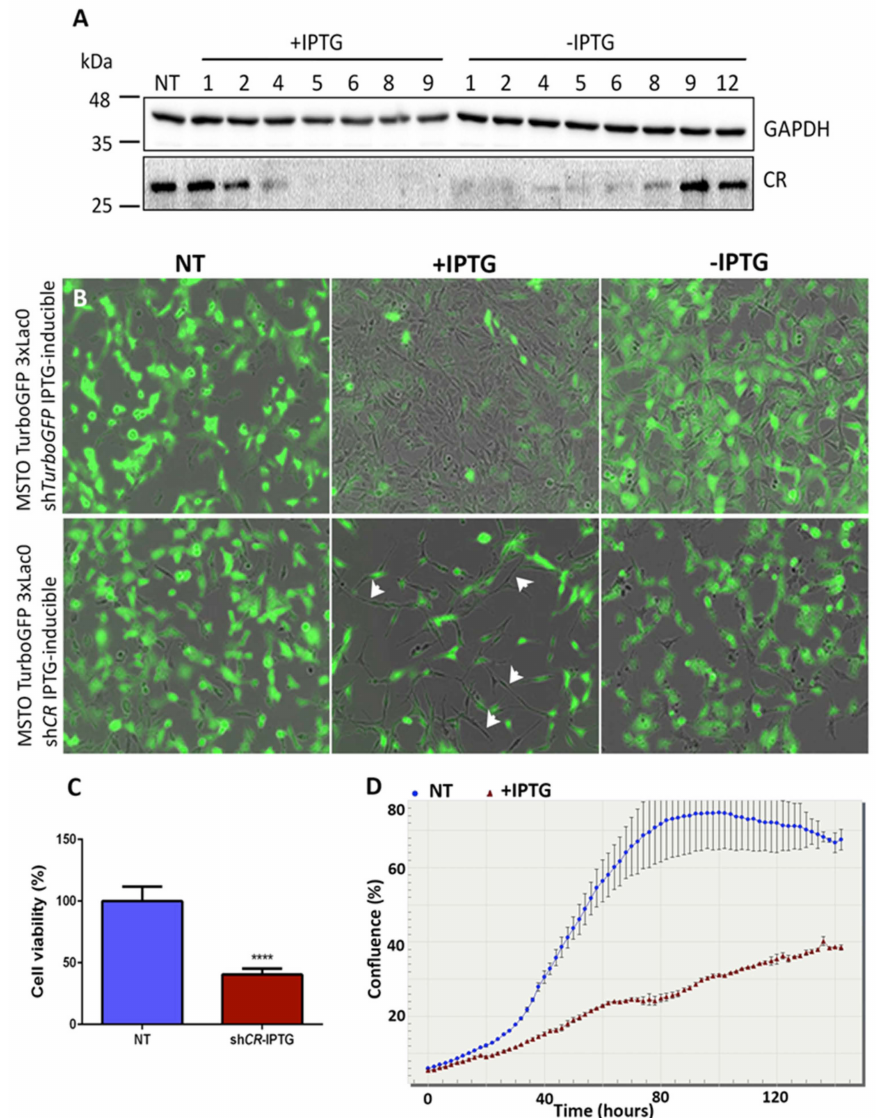
Figure 1. CR downregulation with a shCALB2- IPTG inducible system. ( A ) Western blot analyses of extracts from MSTO-shCALB2-IPTG cells induced with IPTG for nine days ( + IPTG) and after IPTG removal(-IPTG)upto12days.GAPDHwasusedasloadingcontrol.( B )ImagesofMSTO-shCALB2-IPTG induced cells compared with MSTO-shTurboGFP (wt; control) cells; images are overlays of brightfield and fluorescence images. Untreated cells are composed of both, sarcomatoid (spindle-shaped) and epithelioid cells. Addition of IPTG to MSTO-wt cells (upper part) reduces green fluorescence in many cells without a ff ecting cell proliferation and cell morphology. IPTG removal (-IPTG) restores the green fluorescence. Addition of IPTG to MSTO-shCALB2-IPTG cells considerably decreases cell numbers and the few surviving cells are mainly composed of spindle-like cells (lower panel, arrowheads). IPTG removal reverts morphology to the pre-IPTG state with the characteristic biphasic morphology (majority of cells display epithelioid morphology). ( C ) Cell number / viability, determined by an MTT assay shows a decrease in the number of viable MSTO-shCALB2-IPTG cells by approximately 60% ( p ≤ 0.0001) after nine days of IPTG treatment when compared with non-treated cells. ( D ) Real-time growthcurvesofMSTO-shCALB2-IPTGcellstreatedwithIPTG( red )orgrowninabsenceofIPTG( blue